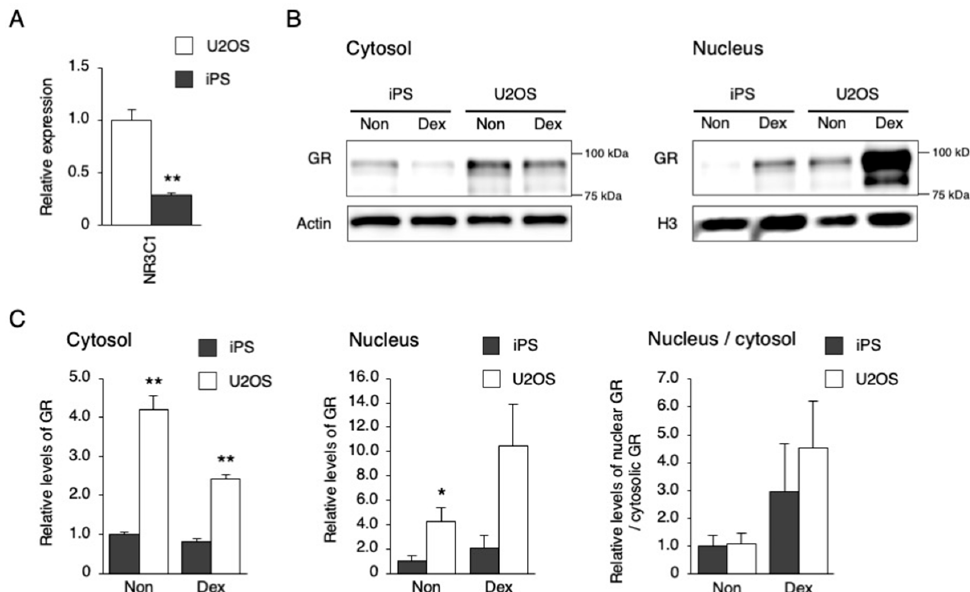
Figure 2. Cell cycle analysis after Dex and Frk stimulation in hiPSCs. Percentage of the cells in G0/G1; the S and G2/M phase in the hiPSCs after Dex or Frk stimulation is shown in the graph. Data are presented as the means ± SEM; n = 3 for each comparison.